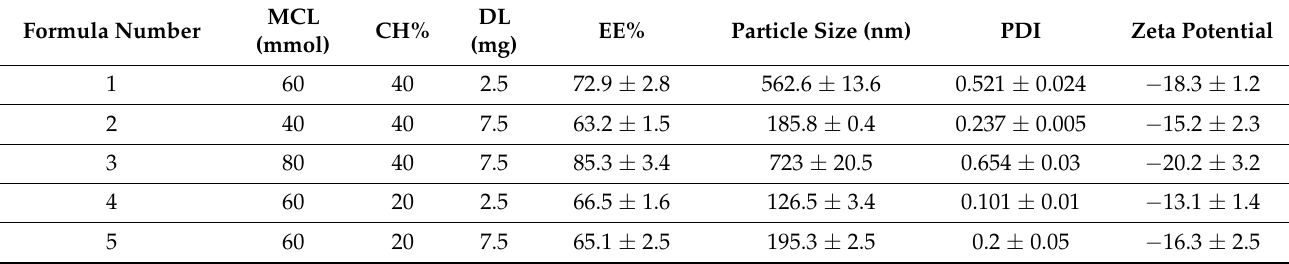
Table 1. Components and physical properties of the formulated propolis loaded